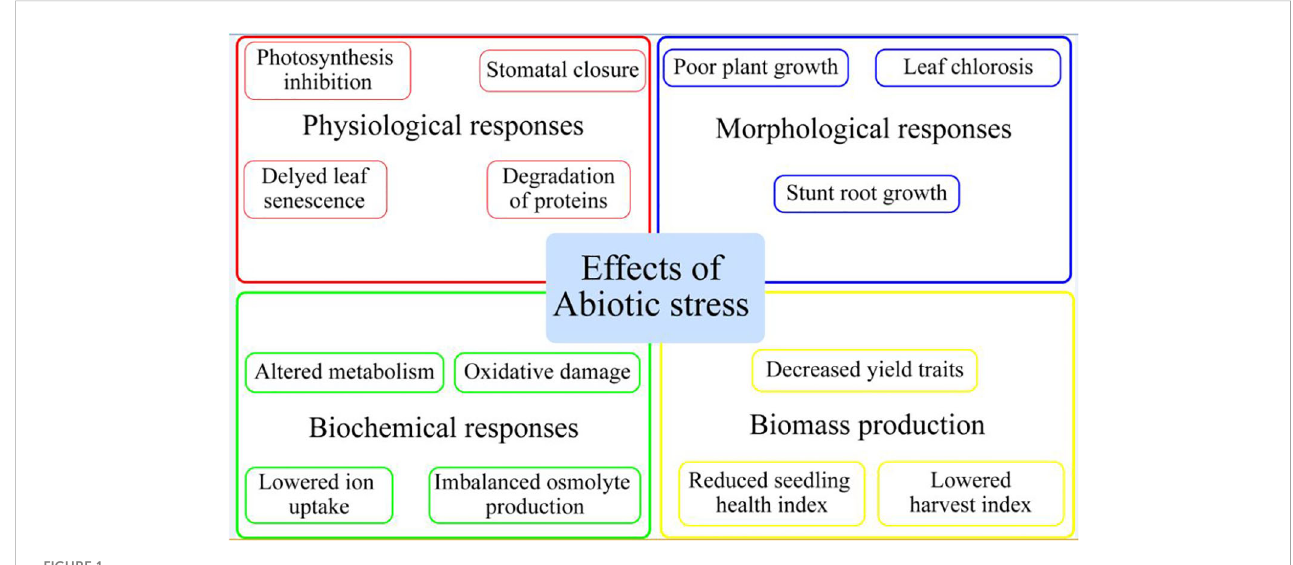
FIGURE 1 Effect of abiotic stress on horticultural